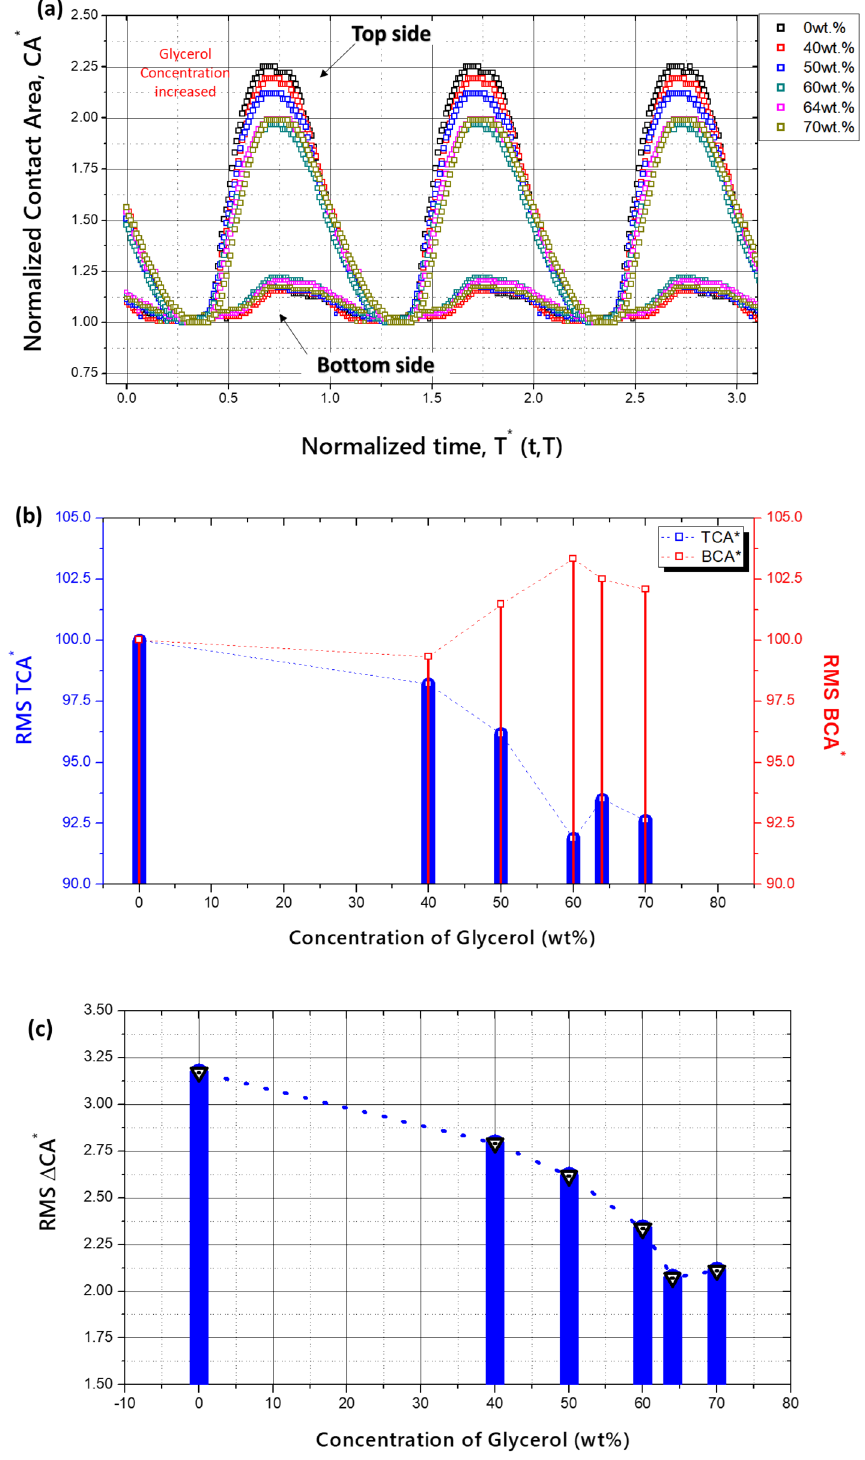
Figure 10. Contact area according to the glycerol concentration. ( a ) Normalized contact area, ( b ) root mean squared normalized contact area, and ( c ) differential contact area between bottom and top